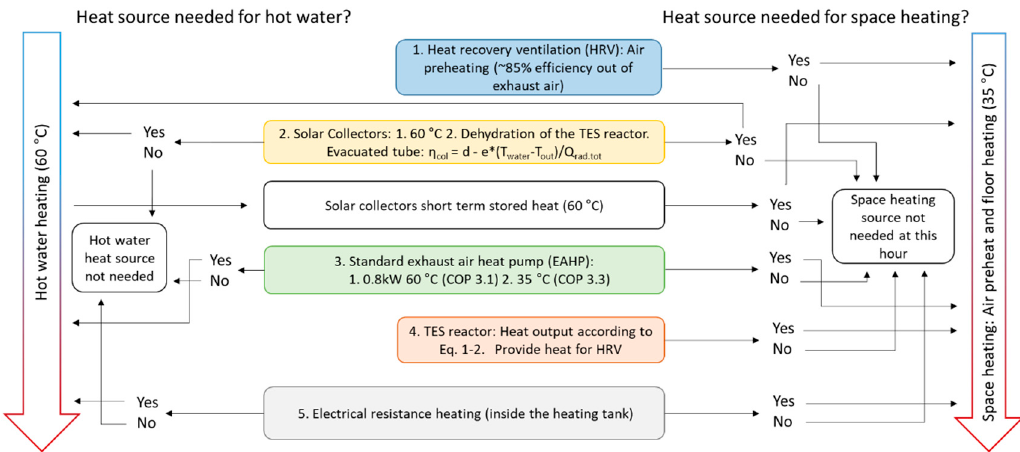
Figure 2. The model algorithm and logic of taking heat sources into use for the case study building. Constants for evacuated tube solar collectors are d = 0.79 and e = 0.67.